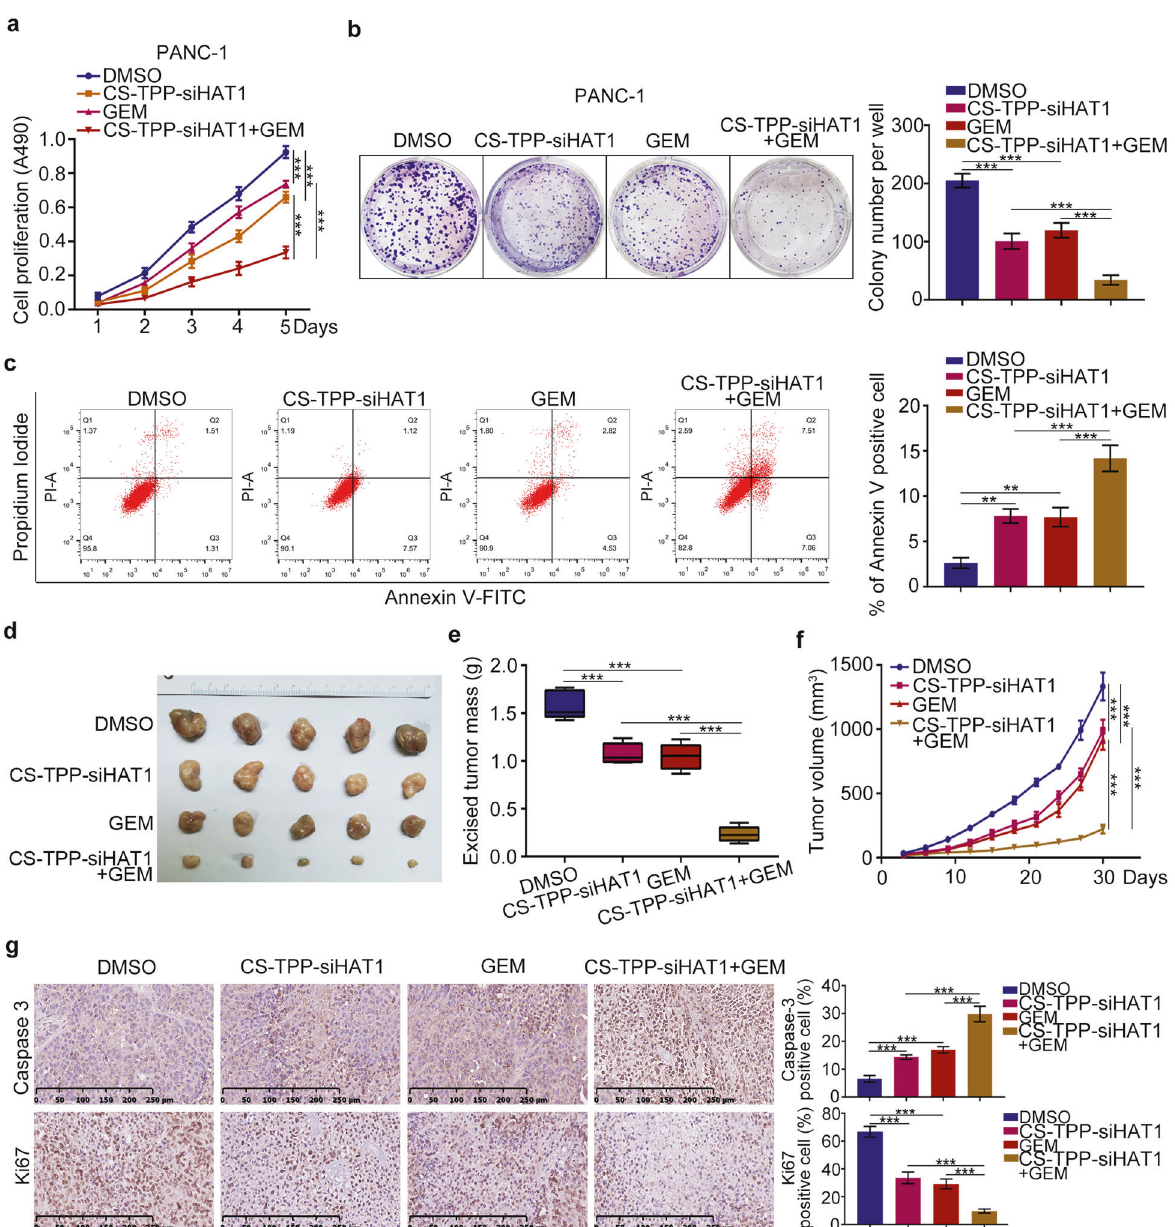
Fig. 6 CS-TPP-siHAT1 augments the ability of gemcitabine to inhibit pancreatic cancer cell growth. a – c PANC-1 cells were treated with CS- TPP-siHAT1 alone, gemcitabine alone or the combination for MTS assay ( a ), clone formation assay ( b ), and Annexin-V/Propidium Iodide assay ( c ). All data were shown as mean values ± SD ( n = 3). ** P < 0.01; *** P < 0.001. d – f PANC-1 cells were subcutanousely injected into the nude mice. These mice were injected intraperitoneally with CS-TPP-siHAT1 (50 μ M) alone, gemcitabine (10 mg/kg) alone or the combination every 3 days. The tumor volume was measured every 3 days and all tumors were harvested for photograph and weight after 30 days ( n = 5). *** P < 0.001. g All tumors were conducted caspase-3 and Ki67 analysis by IHC staining. All data were shown as means values ± SD ( n = 5). *** P <